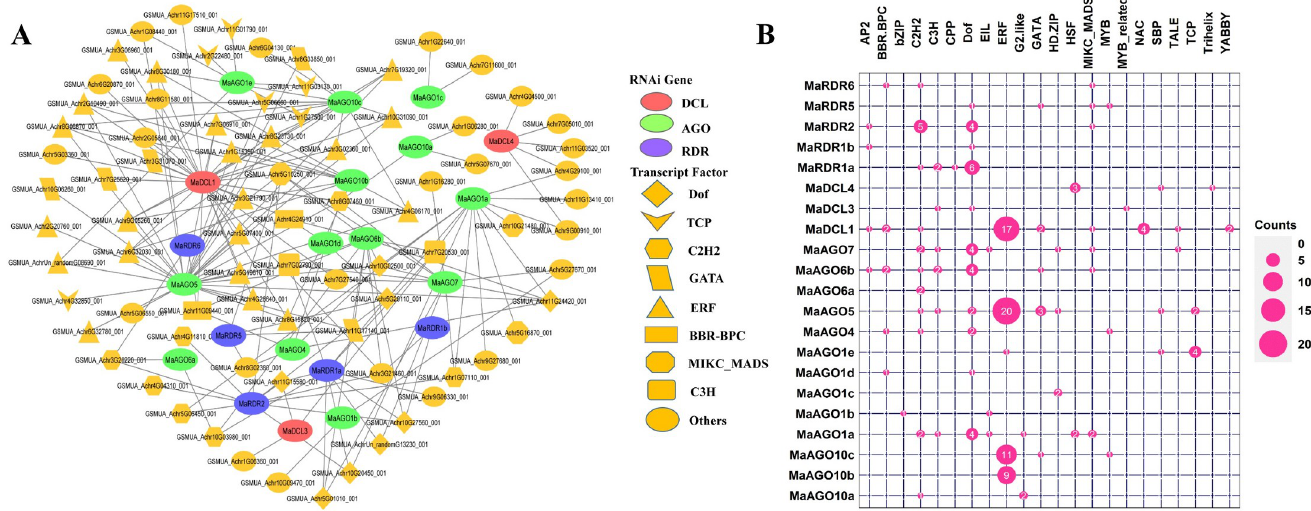
Fig 12. (A) The regulatory network among the TFs and the predicted RNAi genes. Each node of the network was colored based on RNAi genes and TFs. The MaDCL, MaAGO, and MaRDR genes were represented by pink, green, and blue node color, respectively, and the TFs were represented by yellow node color. Different node symbols were used for different families of TFs. TFs were configured at the hub node level using Magenta (B). The map represents the related number of TFs with the predicted MaRNAi genes.